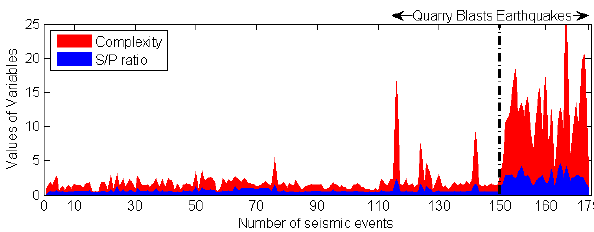
Fig. 2 Distribution of seismic events according to complexity and S/P ratio. There are totally 179 events Fig. 2. Distribution of seismic events according to complexity and S / P ratio. There are totally 179 events in the dataset where 150 in the data set where 150 of them are QBs and 29 of them are EQs. Red color indicates the complexity of them are QBs and 29 of them are EQs. Red color indicates the which has higher values for earthquakes and blue color shows the S/P ratios. complexity, which has higher values for earthquakes, and blue color shows the S / P